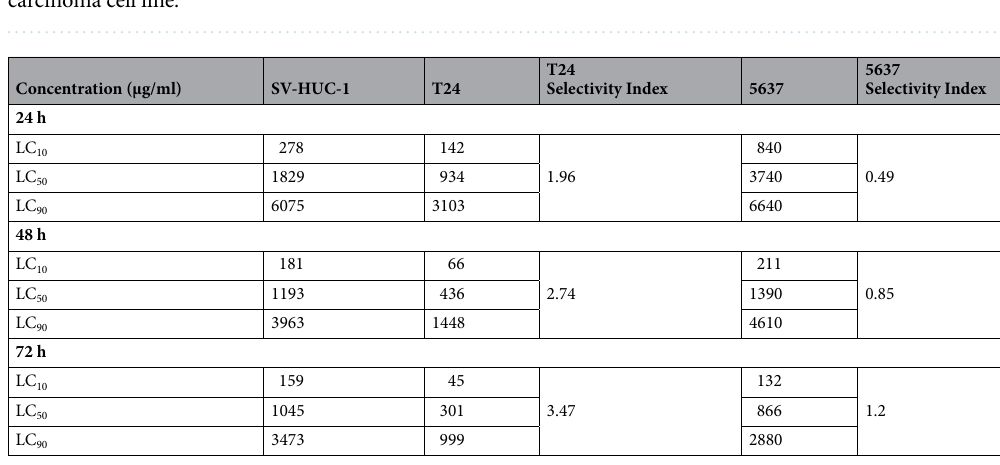
Table 1. Lethal concentrations of Mumio in SV-HUC-1, 5637 and T24 cells, after 24, 48 and 72 h exposures and selectivity indexes for T24 and 5637 cells. All LCs were lower for T24 cells, indicating a higher sensitivity for Mumio. SV-HUC-1—normal urothelial cell line, T24—transitional urinary bladder carcinoma cell line, 5637—grade II urinary bladder carcinoma cell line, LC—lethal concentration.